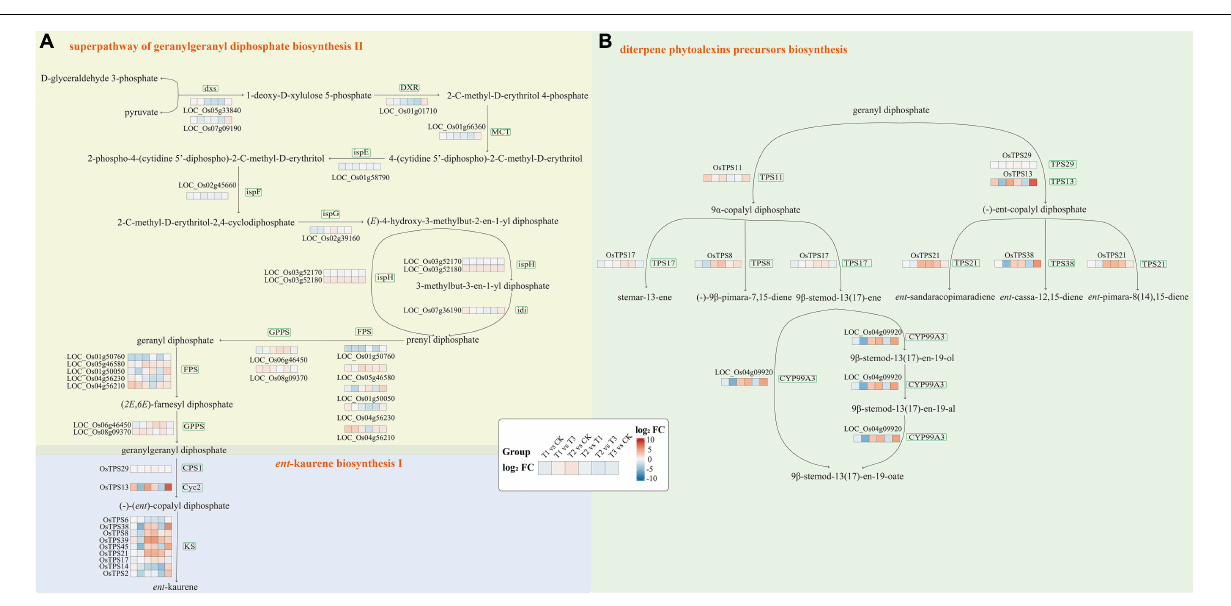
FIGURE 8 | The expression of key genes in and ent-kaurene biosynthesis pathways (A) and diterpene phytoalexins precursors biosynthesis (B)